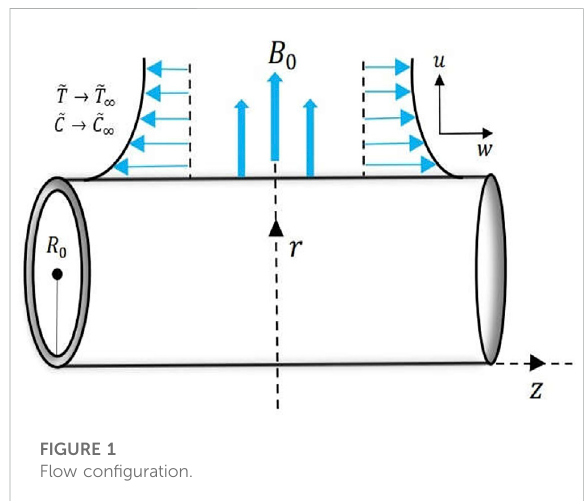
FIGURE 1 Flow con fi guration.